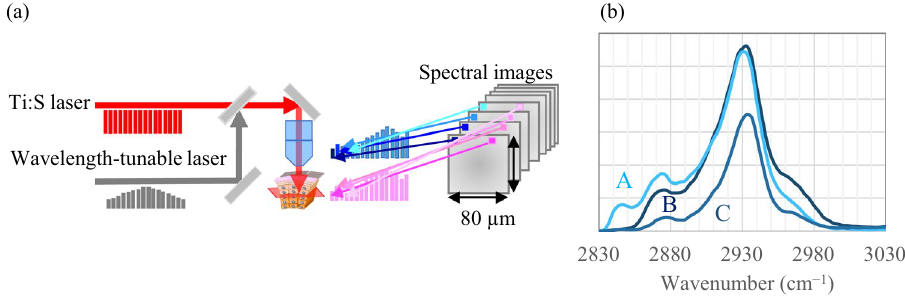
Figure 8. Apparatus overview of stimulated Raman scattering microscopy ( a ) and typical spectra of epidermal layers ( b ); (A) stratum corneum, (B) stratum basale, and (C) stratum